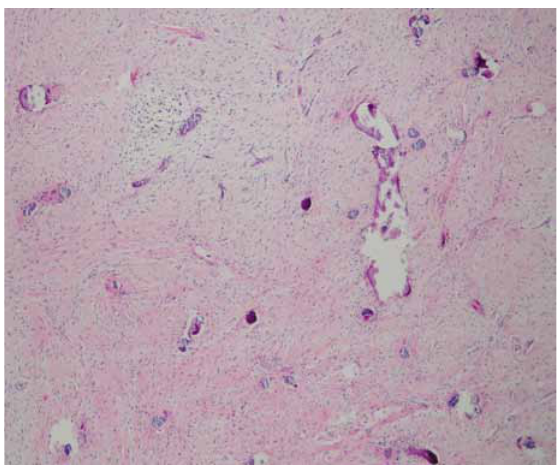
Figure 2. Inactive odontogenic epithelium and amorphous calcifi - cations sourrounded by fibrous and focally myxoid tissue. HE. 50x.